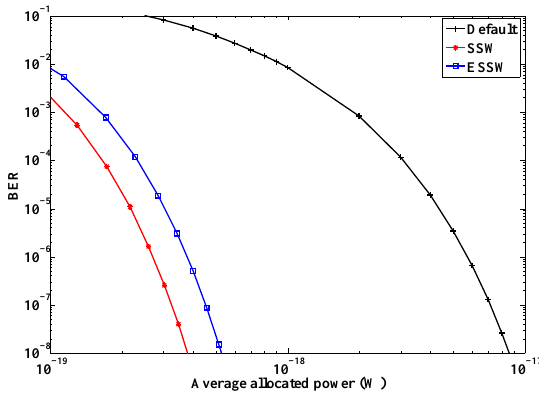
Figure 6: Achievable BER via different protocols as a func- tion of average allocated power for the alveolus